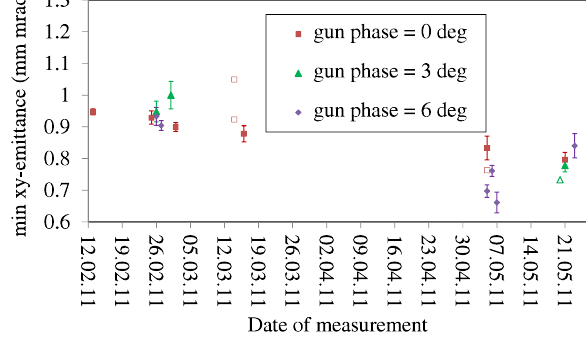
FIG. 19. Measured emittance versus date of measurement for different gun phases w.r.t. the MMMG phase. Solid markers correspond to the results from statistics measurements (see Sec. IVA 6) whereas empty markers depict minimum values directly from solenoid scans (see Sec. IVA 5).